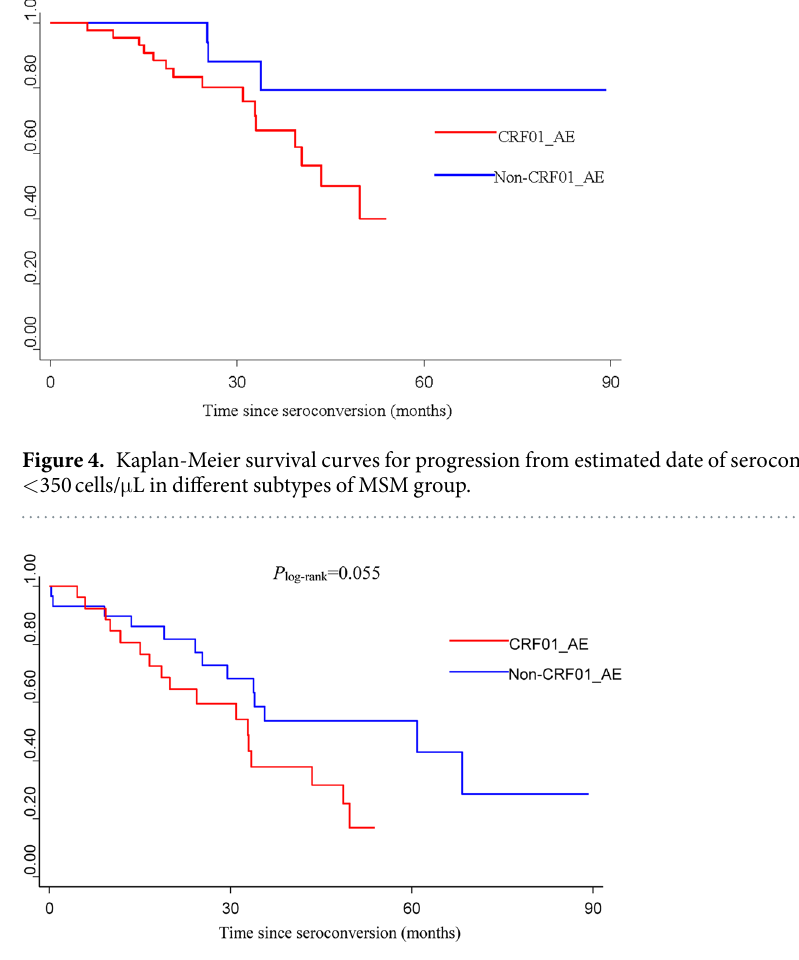
Figure 5. Kaplan-Meier survival curves for progression from estimated date of seroconversion to CD4 count < 350 cells/ μ L in different subtypes of lower baseline CD4 count group (350–499).